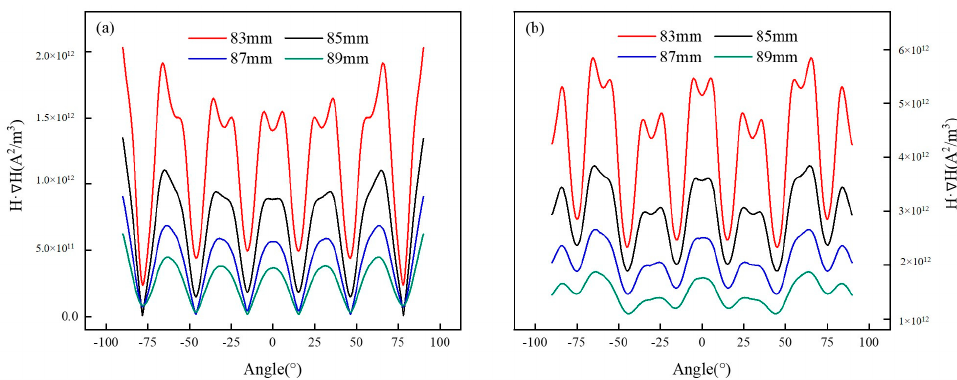
Figure 14. Comparison of distribution of magnetic lines of force between N-N arrangement ( a ) and N-S arrangement ( b ) ( 𝐵 (cid:3045) = 1.2 T).